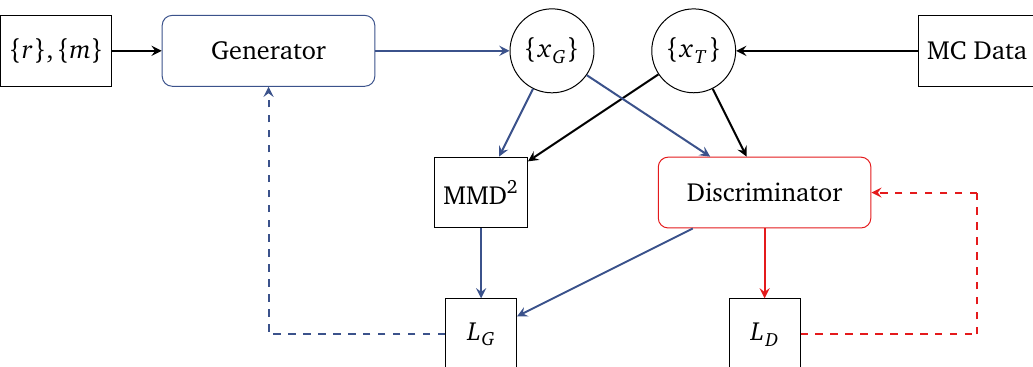
Figure 3: Schematic diagram for our GAN. The input { r } and { m } describe a batch of random numbers and the masses of the external particles, and { x } denotes a batch of phase space points sampled either from the generator or the true data. The blue (red) and arrows indicate which connections are used in the training of the generator